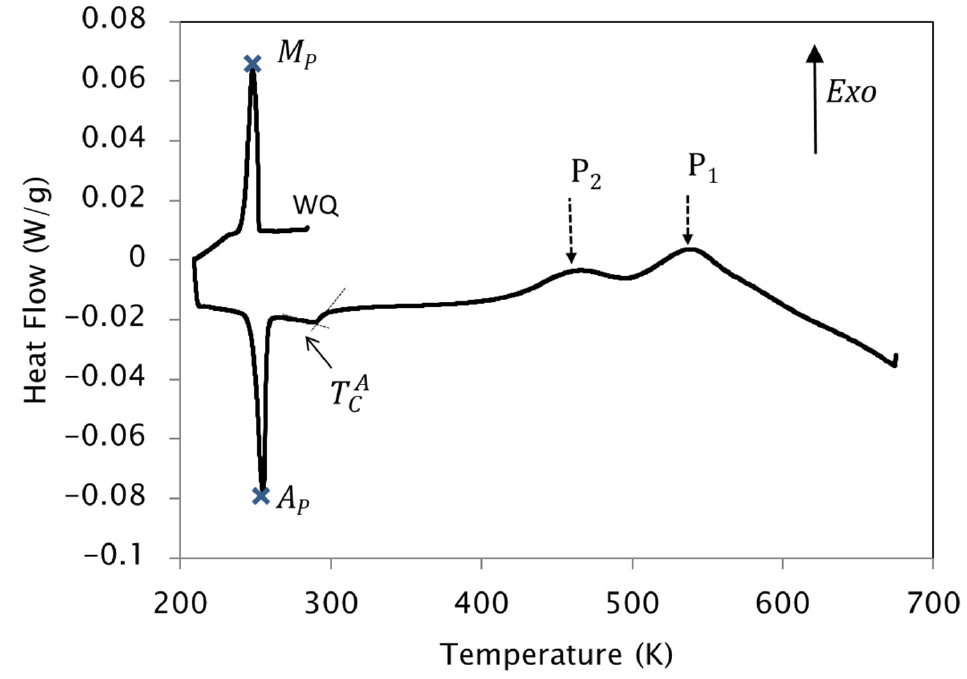
Figure 1. DSC curve obtained on cooling and subsequent heating, at temperature rate of 5 K/min, for a Cu 5 sample as-quenched from 1020 K. The temperatures taken as characteristic for the structural ( M P and A P ) and magnetic transitions ( T A ) are labelled. Adapted from [22].